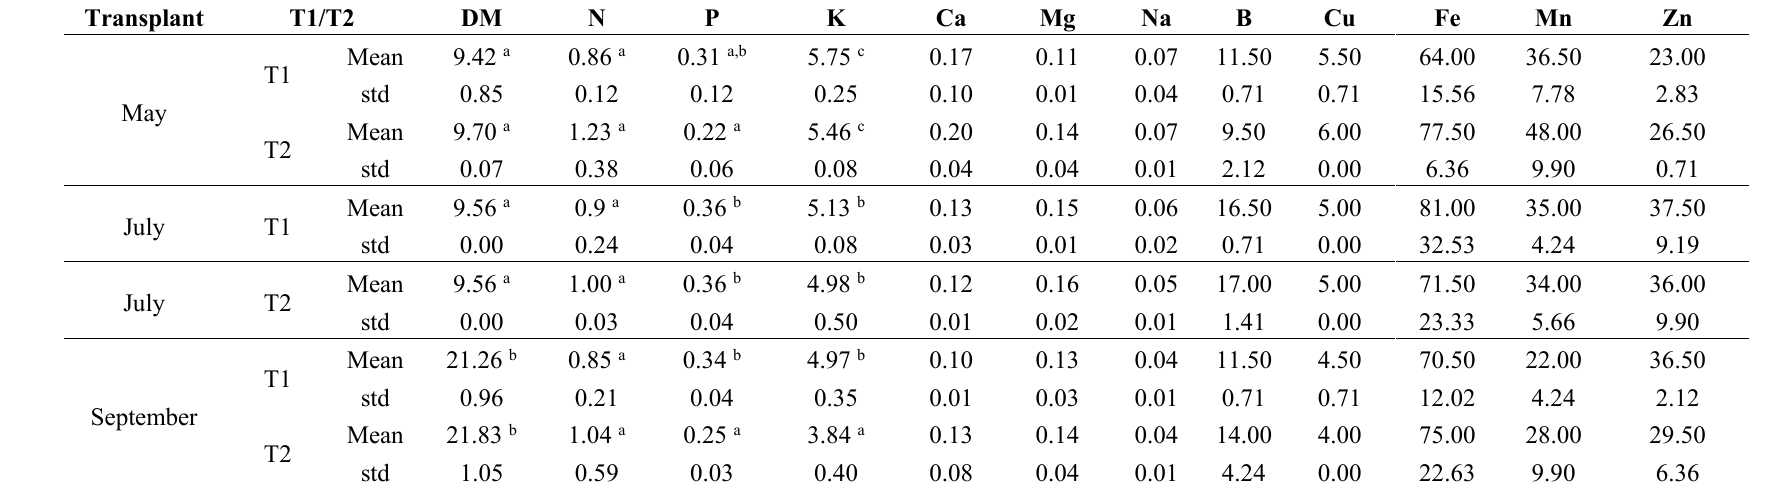
Table 2. Determination of dry matter (DM, expressed in %), nitrogen (N), phosphorus (P) potassium (K), calcium (Ca), magnesium (Mg) and sodium (Na), expressed in% and other elements (expressed in mg/kg): boron (B), copper (Cu), iron (Fe), manganese (Mn) and zinc (Zn) for forage harvested at different dates and for each of the treatments, T1 and T2, expressed by mean and standard deviation. Transplant